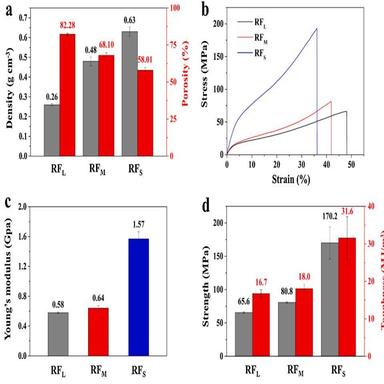
(a) Densities and porosities of RFL, RFM and RFS, (b) Typical tensile stress-strain curves for RFL, RFM and RFS, (c) Young's modulus, and (d) Strength at break and toughness of RFL, RFM and RFS.